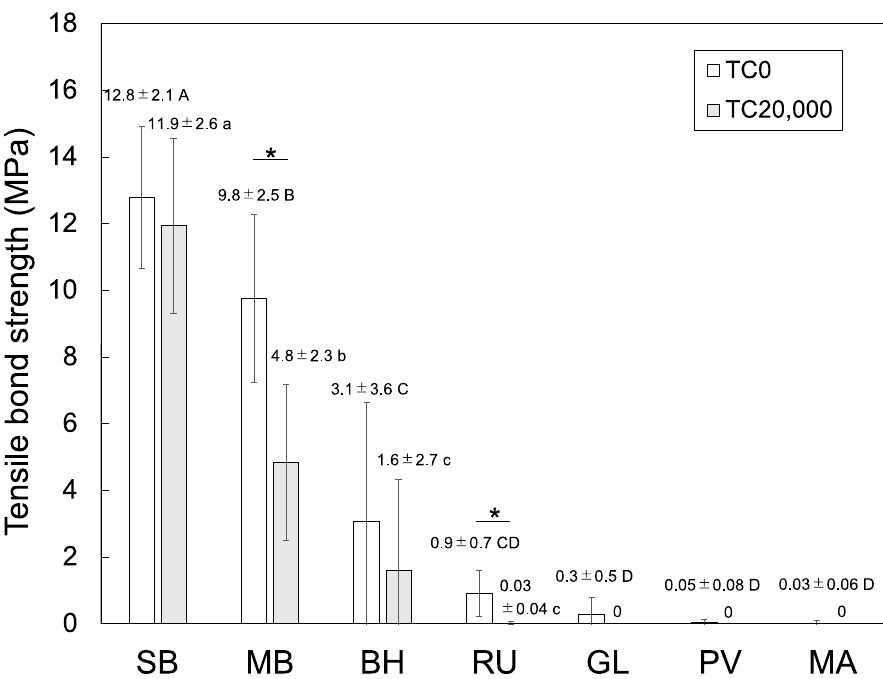
Figure 3. Mean and standard deviations of the TBSs of the various experimental groups. Different uppercase and lowercase letters represent statistically significant differences among the non-thermocycled (TC0) and thermocycled (TC20,000) groups, respectively. An asterisk indicates a statistical difference between the TBSs for the TC0 and TC20,000 groups for the same resin cement.